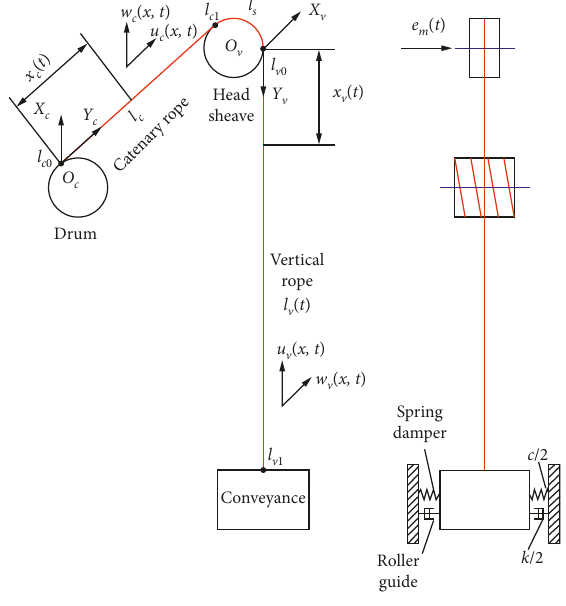
Figure 1: Model of a winding hoisting